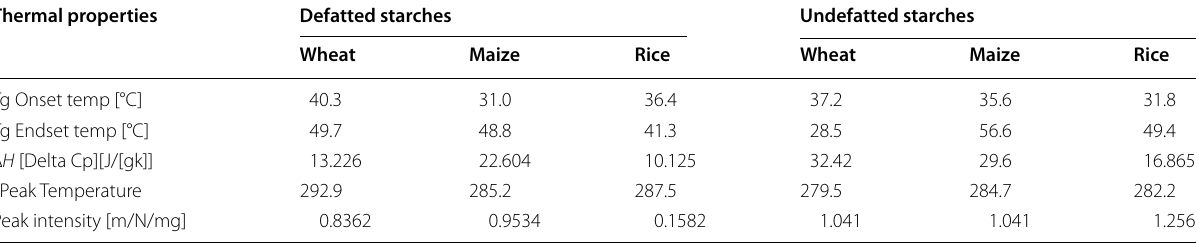
Melting/endothermic Peak temperature [°C] *Key: Tg Glass Transition, ∆H =